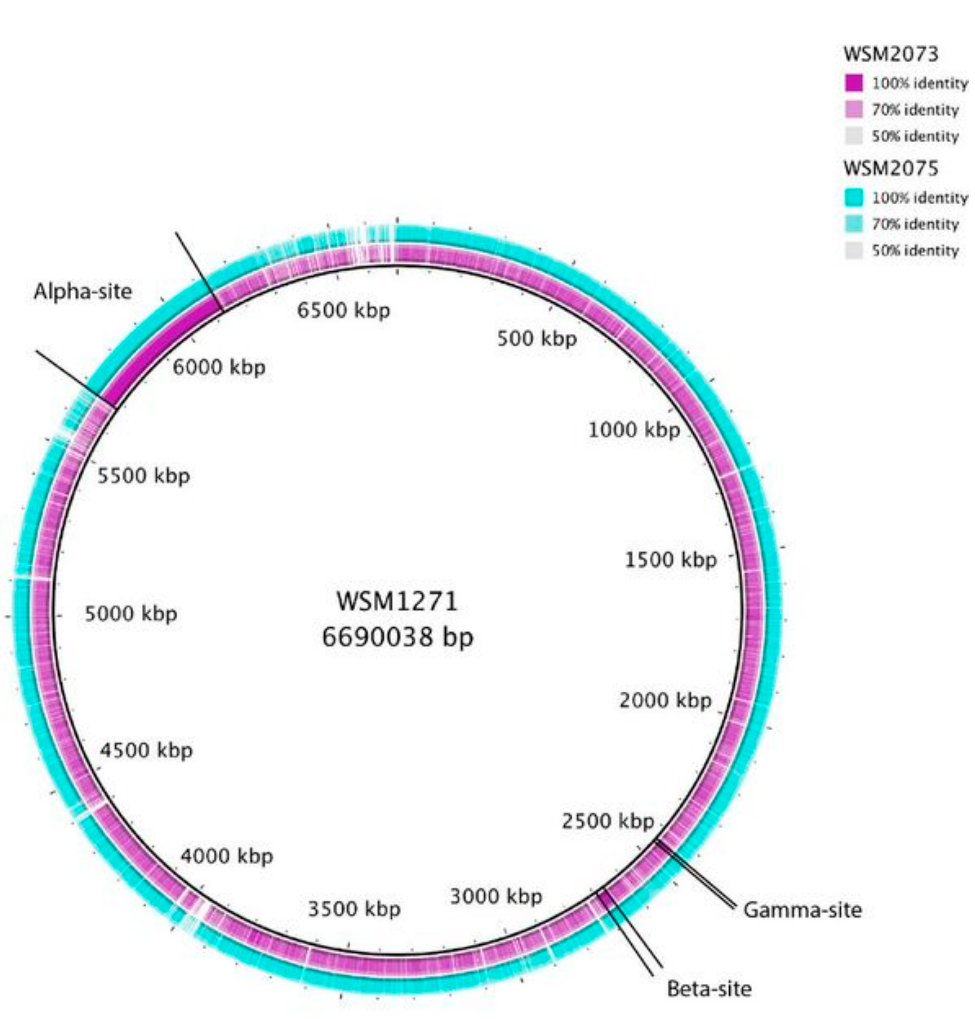
Figure 3. Comparative genome analysis using the circular BLASTN alignment in BRIG (BLAST Ring Image Generator, [124] of WSM2073 and WSM2075 against WSM1271. The three ICE Mc Sym 1271 regions are indicated and summarised from Haskett et al. [123]. It highlights the transfer of the symbiosis island from the Biserrula pelecinus inoculant strain WSM1271 to non-symbiotic recipient strains that turn into poorly effective symbionts. ICE Mc Sym 1271 consists of three separate regions (alpha, beta, and gamma) when integrated in the chromosome but excises as one circular plasmid and re-integrates in the recipient chromosome [123].